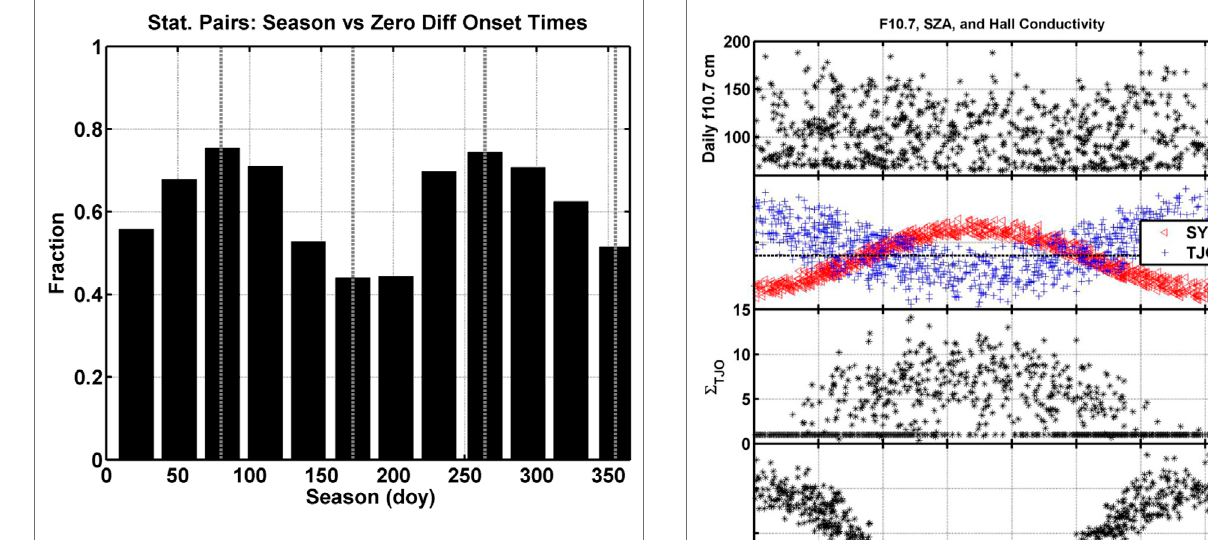
FIGURE 14 | Fraction per bin of differences in onset time with a value of zero as a function of season (doy). The black bars are counts in bins 90 days wide, and the dotted vertical lines mark the equinoxes and the solstices.